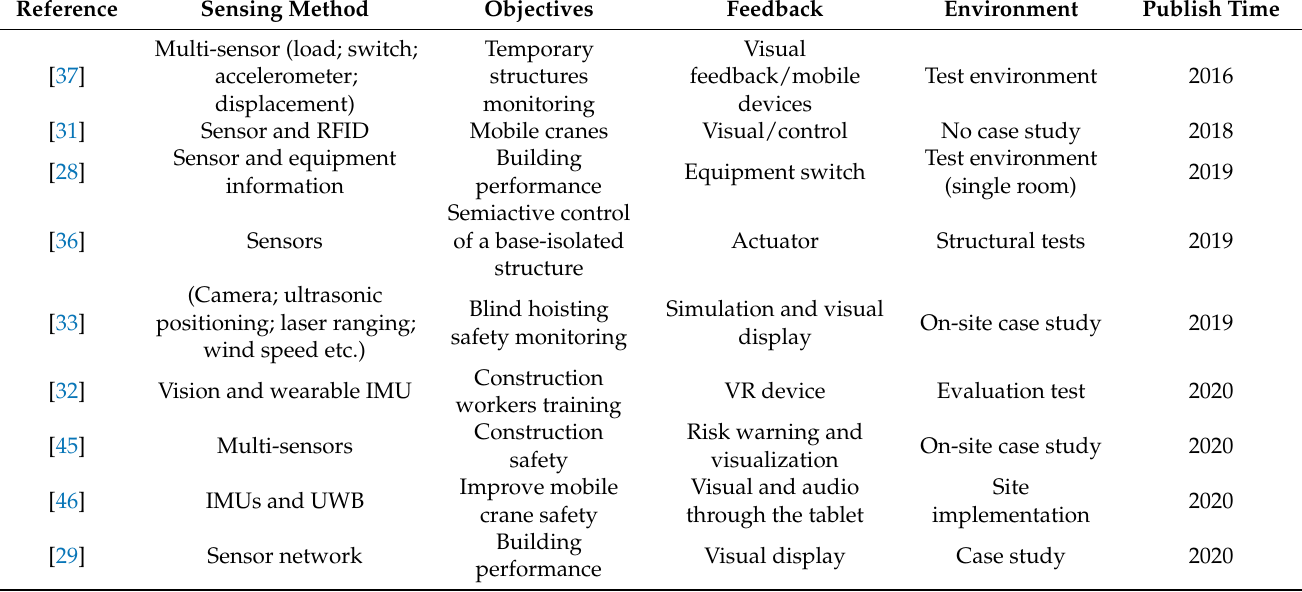
Table 1. CPS in construction